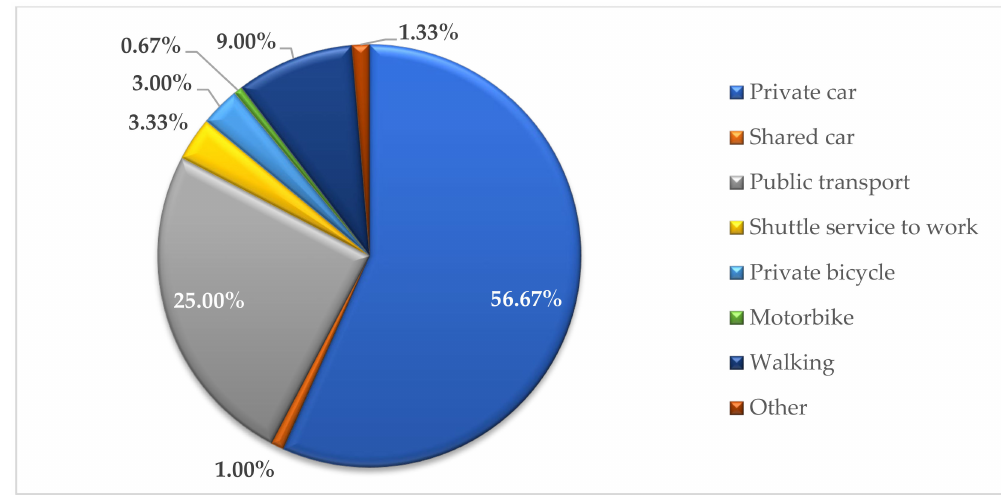
Figure 2. Modal share for the most important trip. (Source: Authors’ survey data).